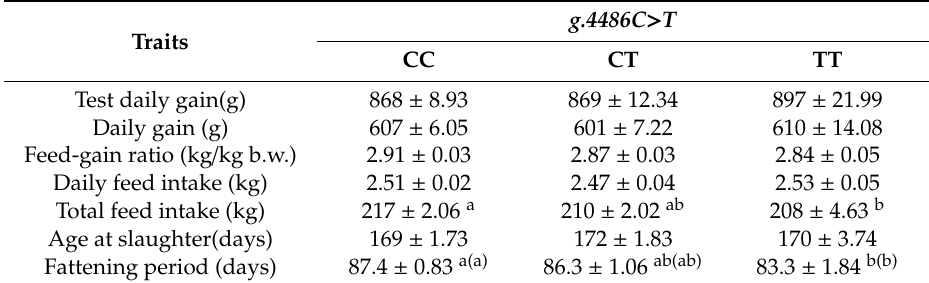
Table 9. Di ff erences in growth and fattening traits between pigs with di ff erent genotypes at the locus g.4486C > T (LSM ±